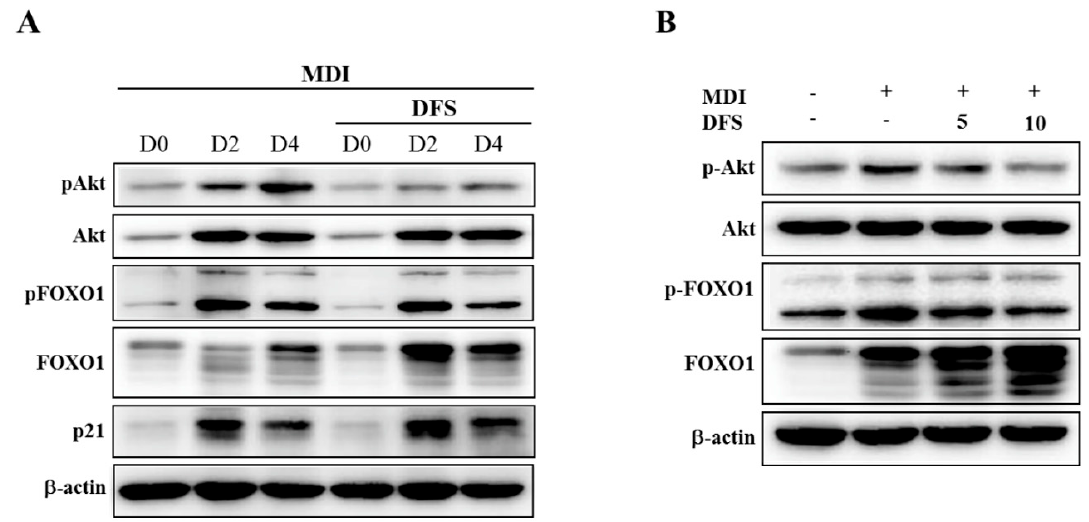
Figure 4. DFS regulates Akt-FOXO1 pathway during adipocyte differentiation. ( A ) Differentiating adipocytes in the presence or absence of DFS (10 µM) were harvested at the indicated periods and analyzed to determine levels of Akt, FOXO, and p21 by western blotting. ( B ) Cells treated with DFS (5 or 10 µM) were harvested on D2 and protein levels of Akt and FOXO1 were analyzed.